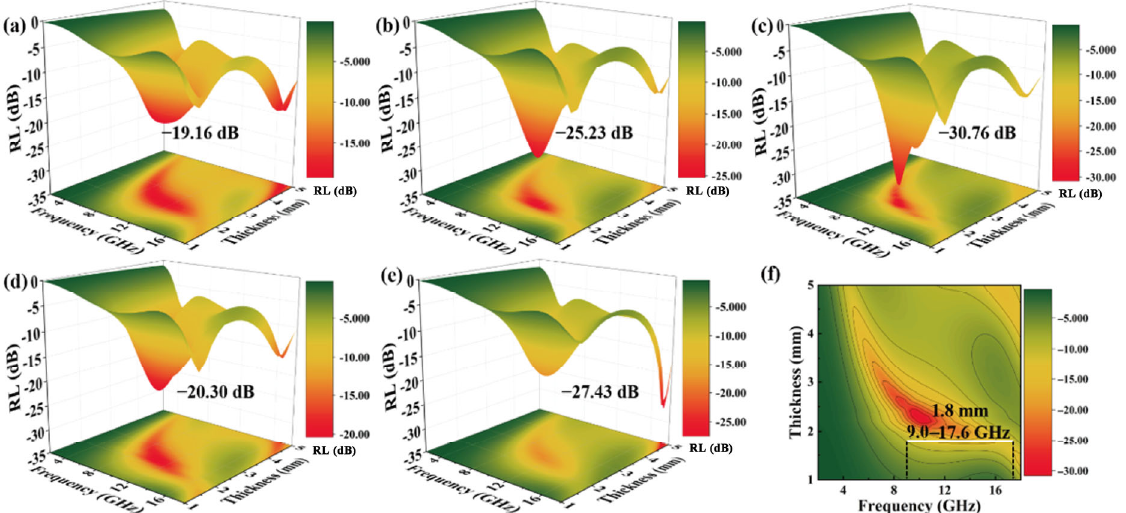
Fig. 6 3D plots of the RL of (a) T1, (b) T2, (c) T3, (d) T4, and (e) T5 in the paraffin matrix. (f) 2D representations of RL connected with different thicknesses of